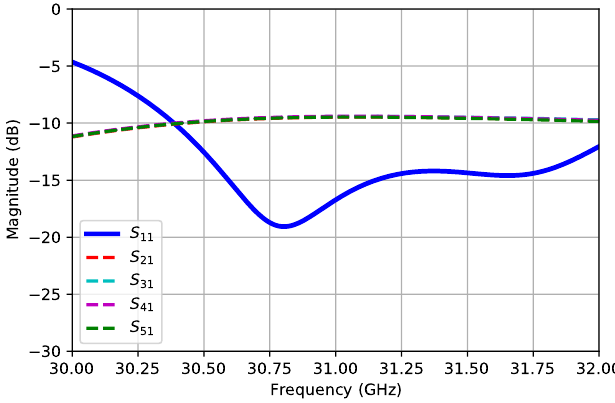
Figure 9. Simulated S-parameters of the corporate feeding network.